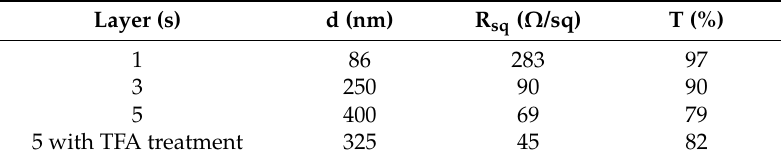
Table 1. The film thickness (d), sheet resistance (R sq ), and transmittance (T) of average value in the visible wavelength for PEDOT:PSS films (PH1000: 4 wt% Sorbitol), which are spin-coated at both 4000 and 6000 rpm, is compared to the result of trifluoroacetic acid (TFA) treatment.